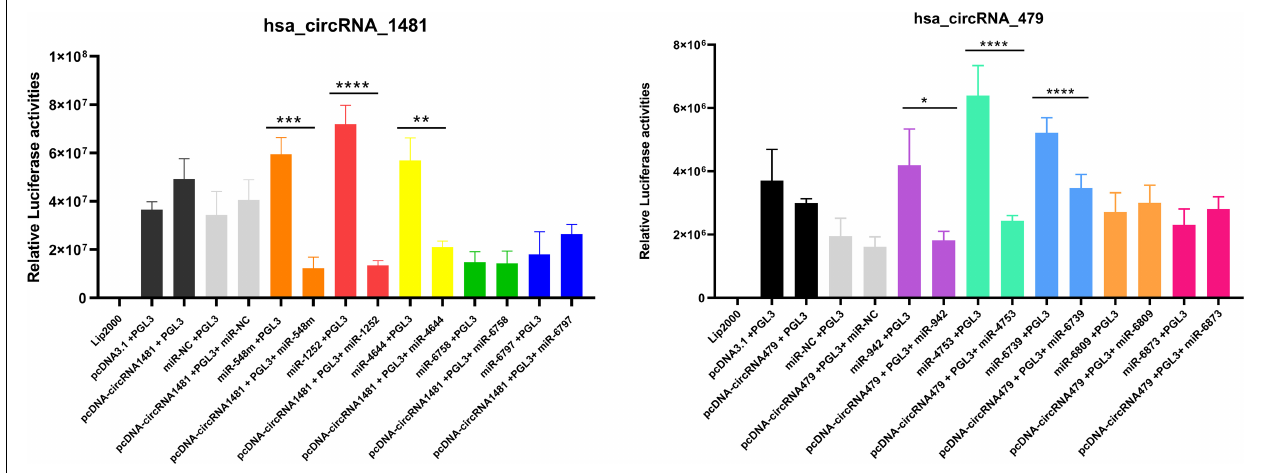
FIGURE 10 | The relative luciferase activities of hsa_circRNA_1481 and hsa_circRNA_000479 showing the expression level of each miRNA. The relative luciferase activities were calculated in HEK293T cells co-transfected by five miRNA mimics are depicted in the bar graph (* P < 0.05, ** P < 0.01, *** P < 0.001, and **** P < 0.0001). Experimental results are expressed as mean ± standard